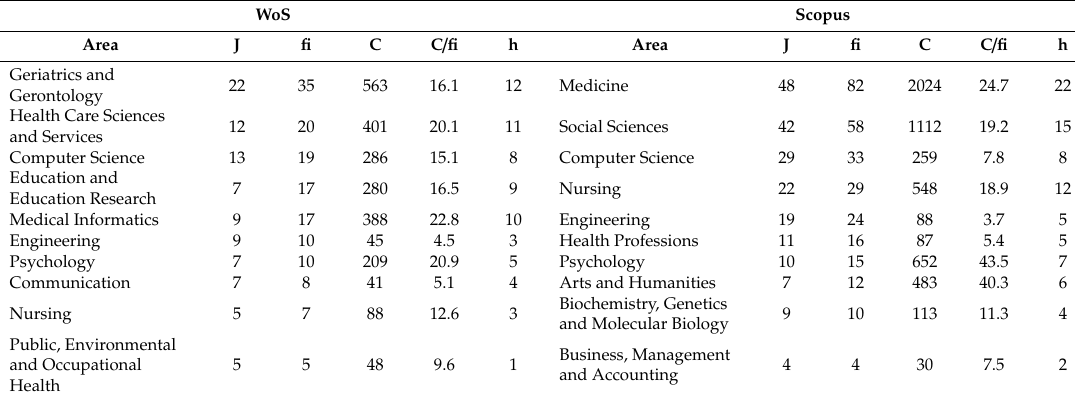
Table 6. Main areas of